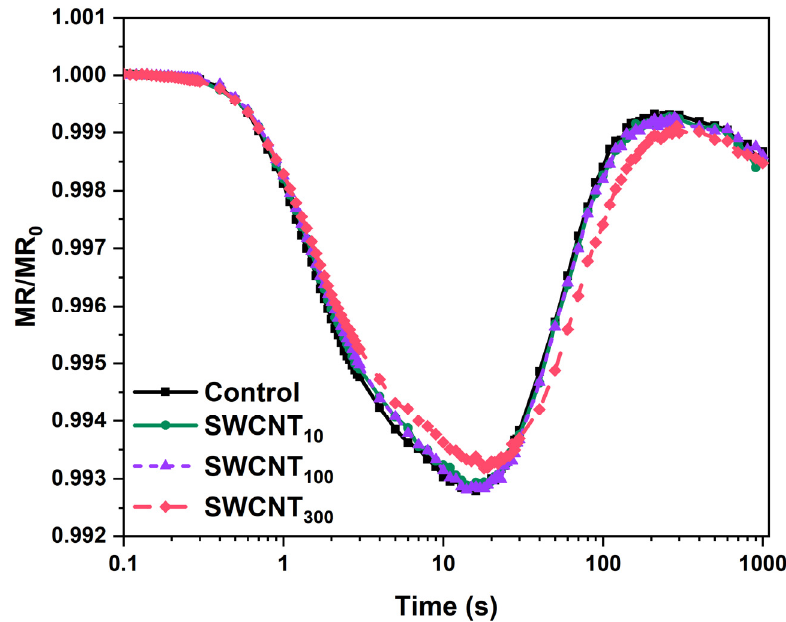
Figure 4. Curves of the modulated reflection (MR) at 820 nm (relative to MR 0 and presented on a semi-logarithmic scale) recorded for intact pea leaves sprayed with distilled water (control), 10, 100 or 300 mg/L SWCNT.